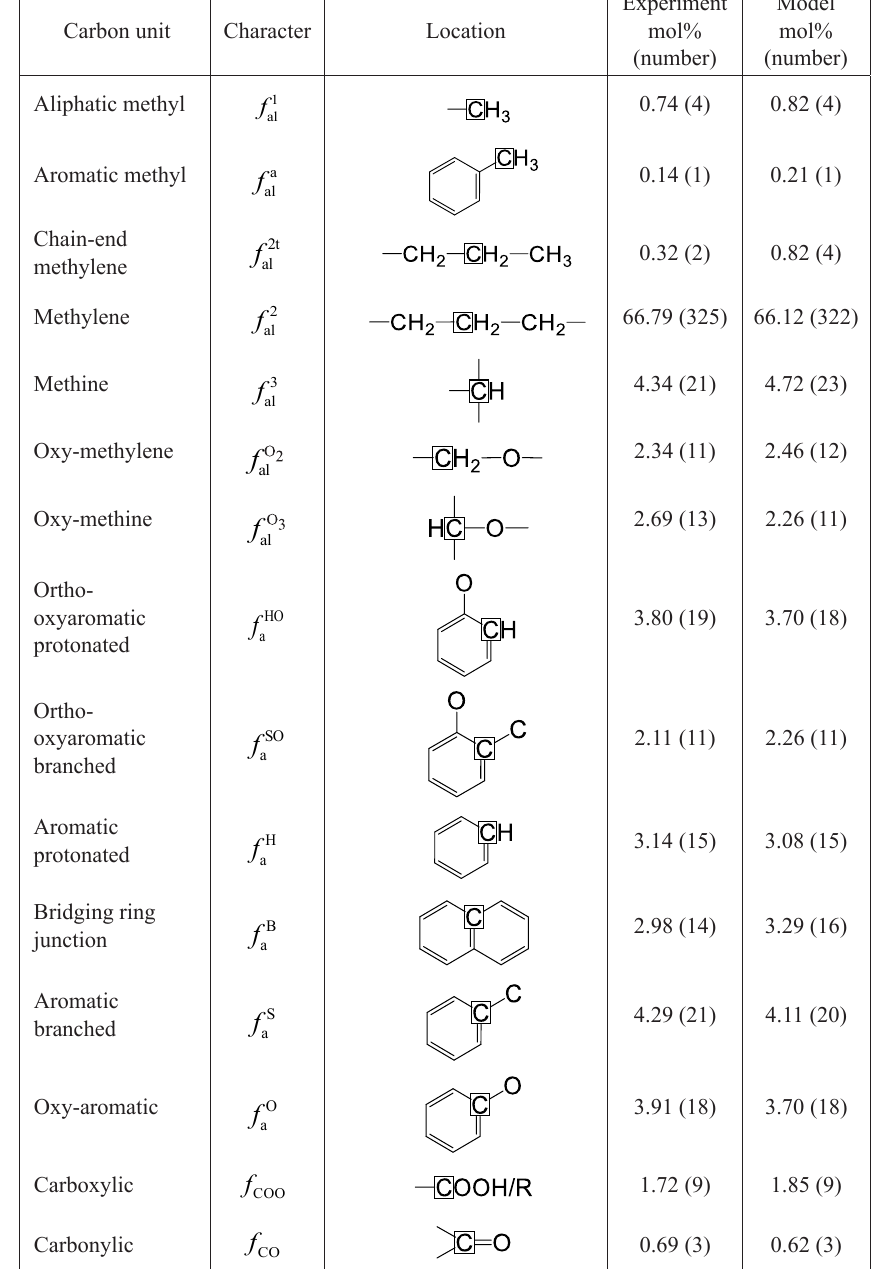
Table 2. Structural data of Dachengzi oil shale kerogen from 13 C DP/MAS SSNMR [35] and the molecular model